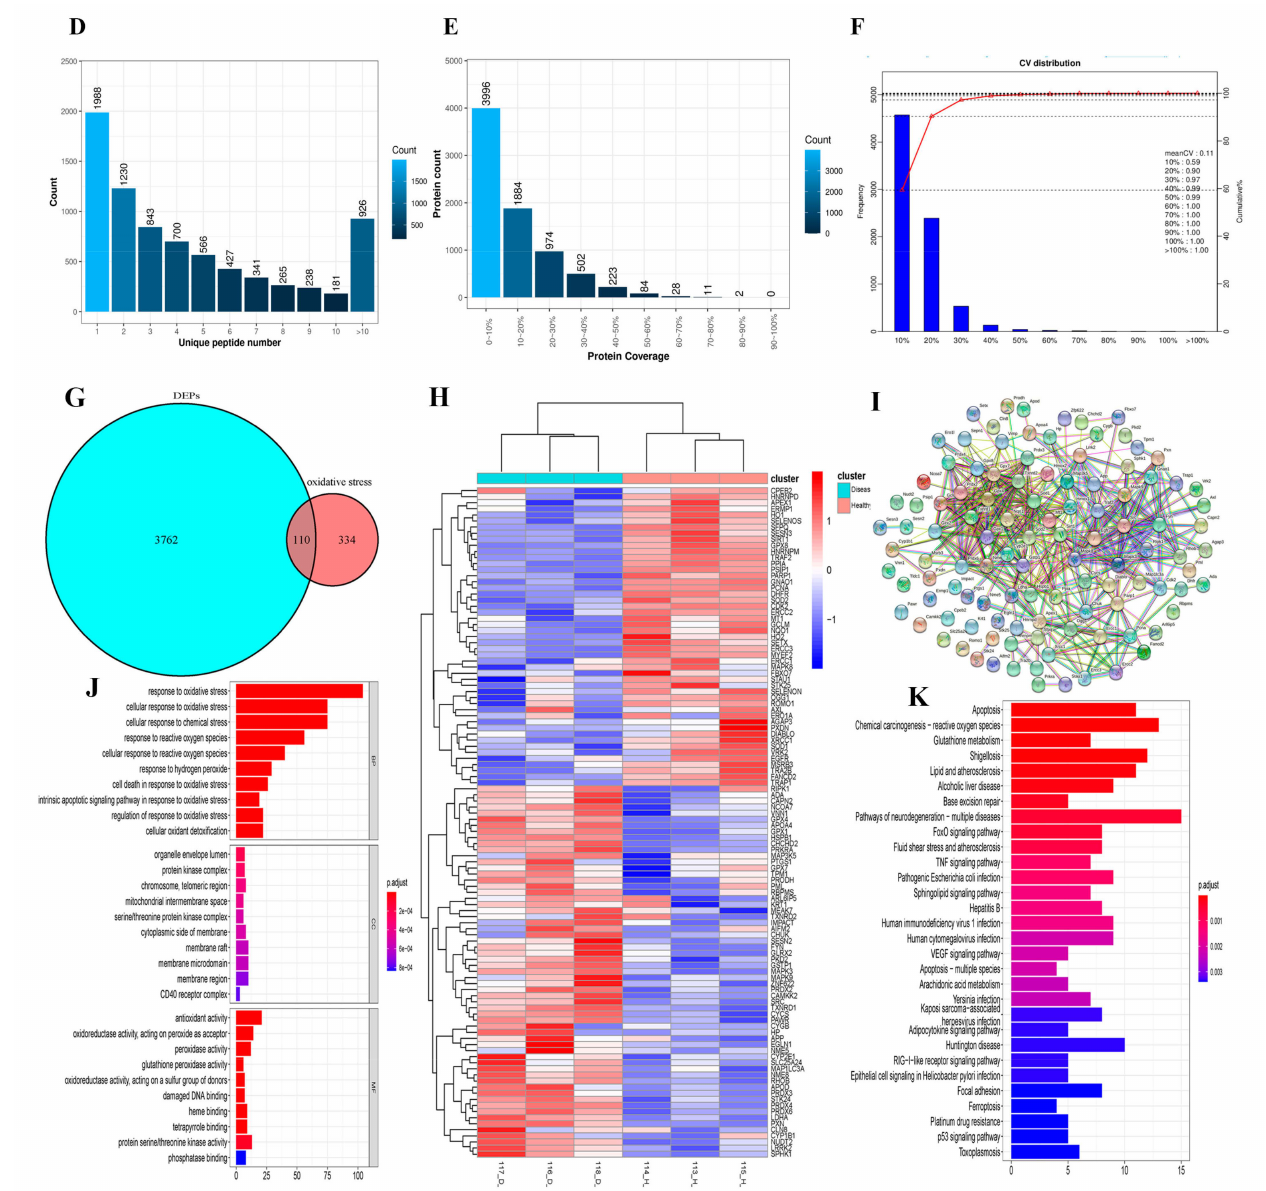
Figure 3. iTRAQ quantitative proteomics of mouse testes during recovery for 17 days after cis- platin/no treatment and the expression of oxidative-stress-related proteins in mice during different recovery periods after cisplatin/non-cisplatin treatment. ( A ) According to iTRAQ proteomic analy- sis, total spectra, spectra, unique spectra, peptides, unique peptides, and proteins were identified. ( B ) Proportional distribution of identified proteins based on their mass. ( C ) Peptide length distribu- tion as a percentage of the total protein length. ( D ) Number of unique peptides that matched the proteins. ( E ) Protein coverage distribution in all of the identified proteins. ( F ) Three repetitions of the coefficient of variation distribution. ( G ) In the testes of the control d17 and CP d17 groups, a Venn diagram was used to identify the differentially expressed proteins associated with oxidative stress. ( H ) Heatmap showing the clustering of 110 DEPs between the control d17 and the CP d17 groups. ( I ) Connections among the 110 differentially expressed proteins relevant to oxidative stress revealed using the PPI network obtained from the STRING database. ( J ) The ordinate indicates the gene’s name, the abscissa shows the number of genes, and the color reflects the adjusted p -value in an enriched gene ontology (GO) analysis of the 110 DEPs linked to oxidative stress. ( K ) Enrichment KEGG pathway analysis of the 110 DEPs related to oxidative stress; the ordinate displays the pathway name, the abscissa displays the differential protein count, and the color represents the adjusted p